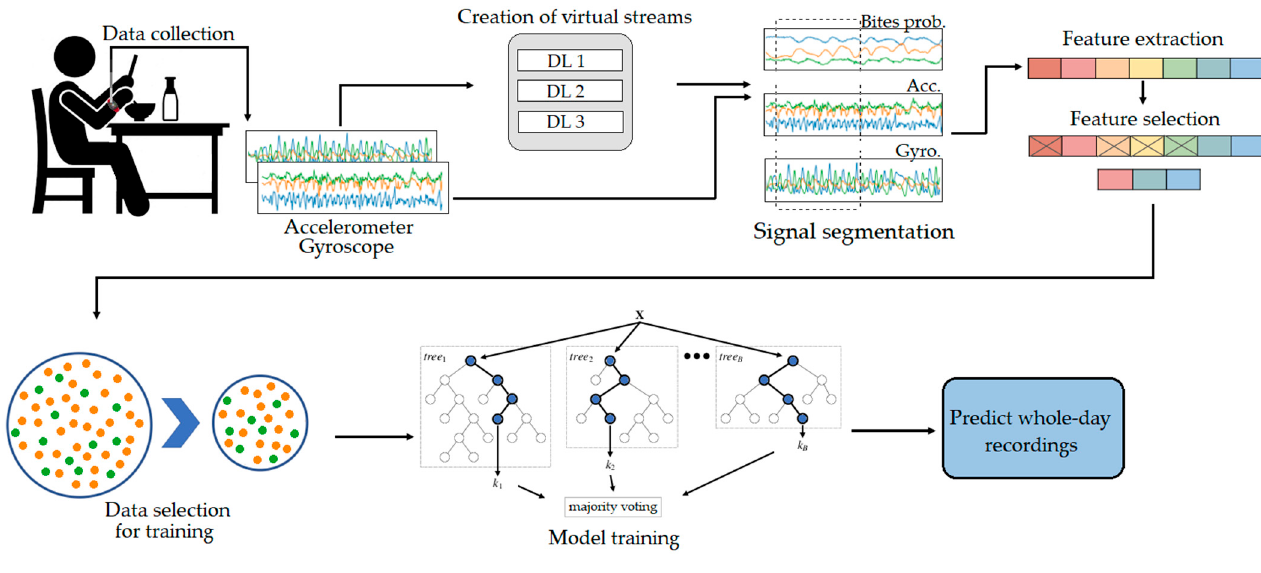
Figure 2. An overall pipeline of the proposed eating detection framework.